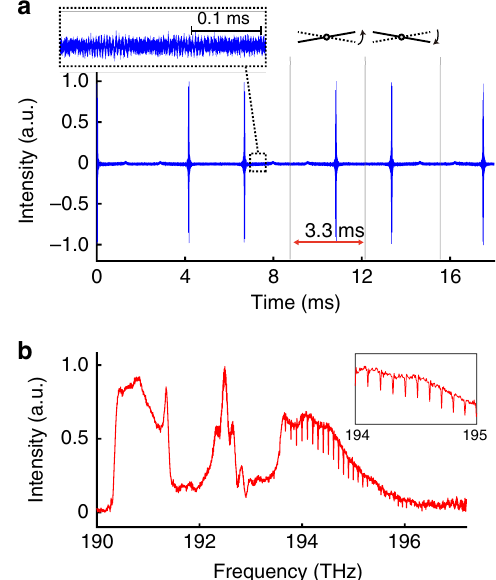
Fig. 4 Broadband spectroscopic measurement by PC-FTS based on a galvanometric scanner. a Continuous interferograms of H 12 C 14 N molecules measured with the mode-locked laser. The single-sided interferograms are continuously obtained at a scan rate of 300 Hz (the corresponding temporal interval is 3.3 ms). The inset shows modulations due to the free- induction decay. b A broadband spectrum obtained by Fourier-transforming a single interferogram. The non-averaged broadband spectrum covering 7 THz shows absorption lines of HCN molecules at a spectral resolution of 10.1 GHz with a high signal-to-noise ratio. The structured spectral pro fi le comes from that of the mode-locked fi ber a continuous measurement of interferograms at a rate of 12 kHz is demonstrated in Fig. 5a. Figure 5b shows the corresponding consecutive broadband C 2 H 2 absorption spectra with a band- width of 1.5 THz at a spectral resolution of 11.5 GHz. The spectra are normalized and converted to transmittance by a baseline fi tting with Savitzky – Golay fi ltering 44 . Note that the effective scan velocity calculated by (scan rate) × (maximum group delay) × c is 340 m s − 1 , which is orders of magnitude higher than those of conventional delay lines. The down-conversion factor, (effective scan velocity)/ c = (scan rate) × (maximum group delay), is about 10 − 6 . Figure 5c shows a 20-averaged spectrum compared to a computationally retrieved spectrum based on HITRAN data- base 45 . The SNR of a single spectrum is 54, which is limited by detector noise in this proof-of-concept demonstration. It could be improved by using a detector with better noise performance. The detailed discussion on SNR is provided in Supplementary Note 3.